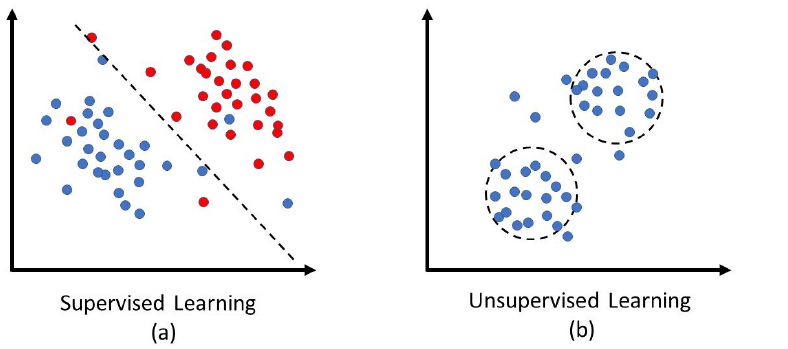
Figure 6. Schematic view of classification vs. clustering. ( a ) Blue: class-1, red: class-2, supervised models learn patterns to discriminate data samples based on their labels. ( b ) Unsupervised model cluster samples (just based on their